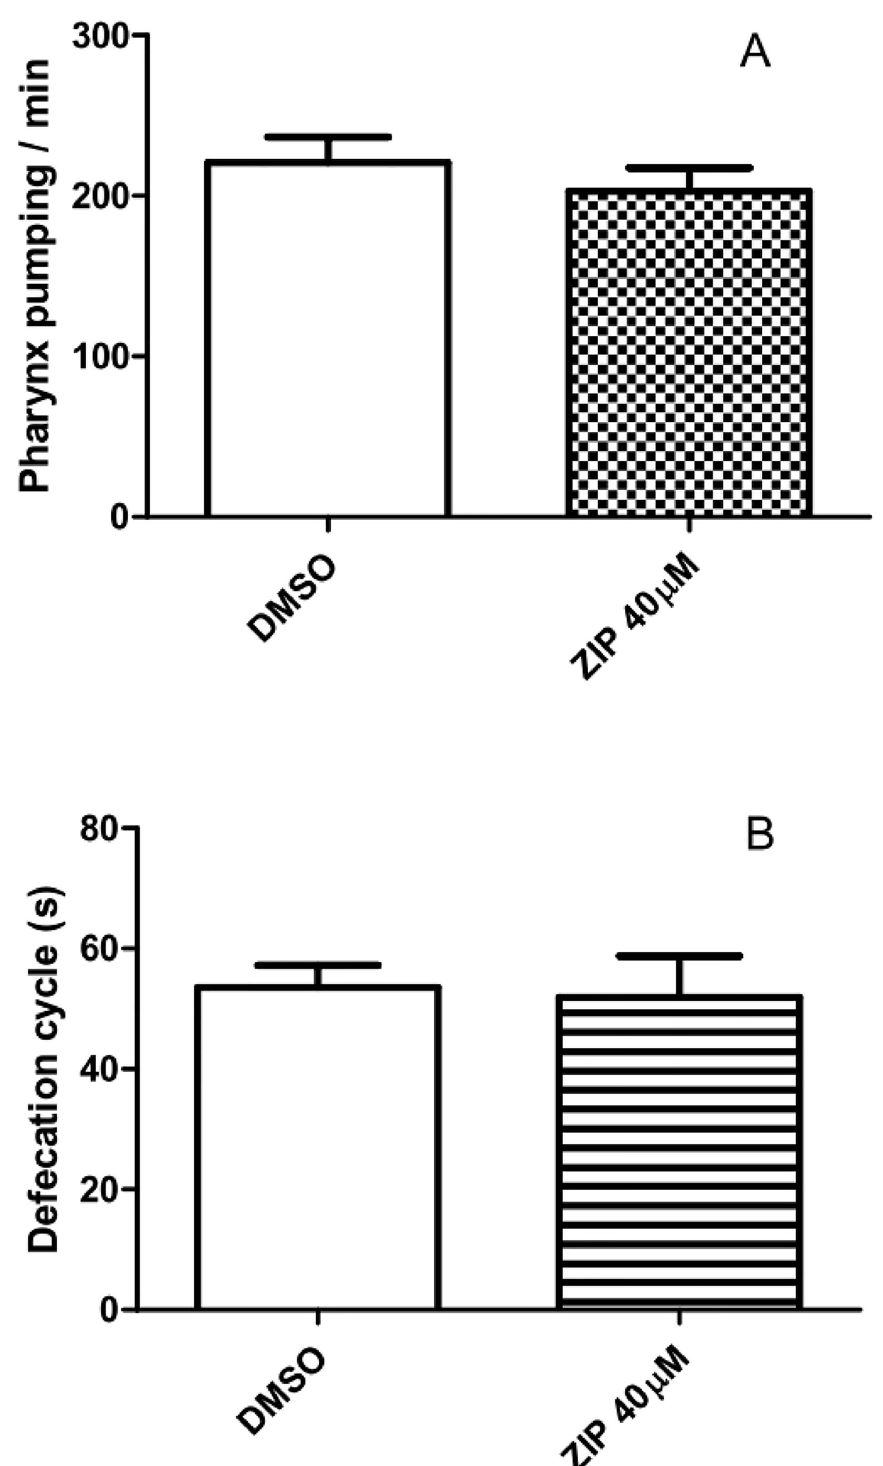
Figure 4. Caenorhabditis elegans wild-type behavior after Ziprasidone treatment for 24h. The worms were observed as the pharynx pumping/ min (A) and intervals of defecation cycles (s) (B) on treatment plates. The treatment with Ziprasidone (40 µM) or control (DMSO 0.16% in Acetic acid (1:10 000)) started in L4 larval stage for 24 h (adult). No statistic difference was found compared to control (0.16% DMSO) (mean, SD, n=20). The drug was poured and precipitated on agar plates. doi: 10.1371/journal.pone.0074780.g004 PLOS ONE |